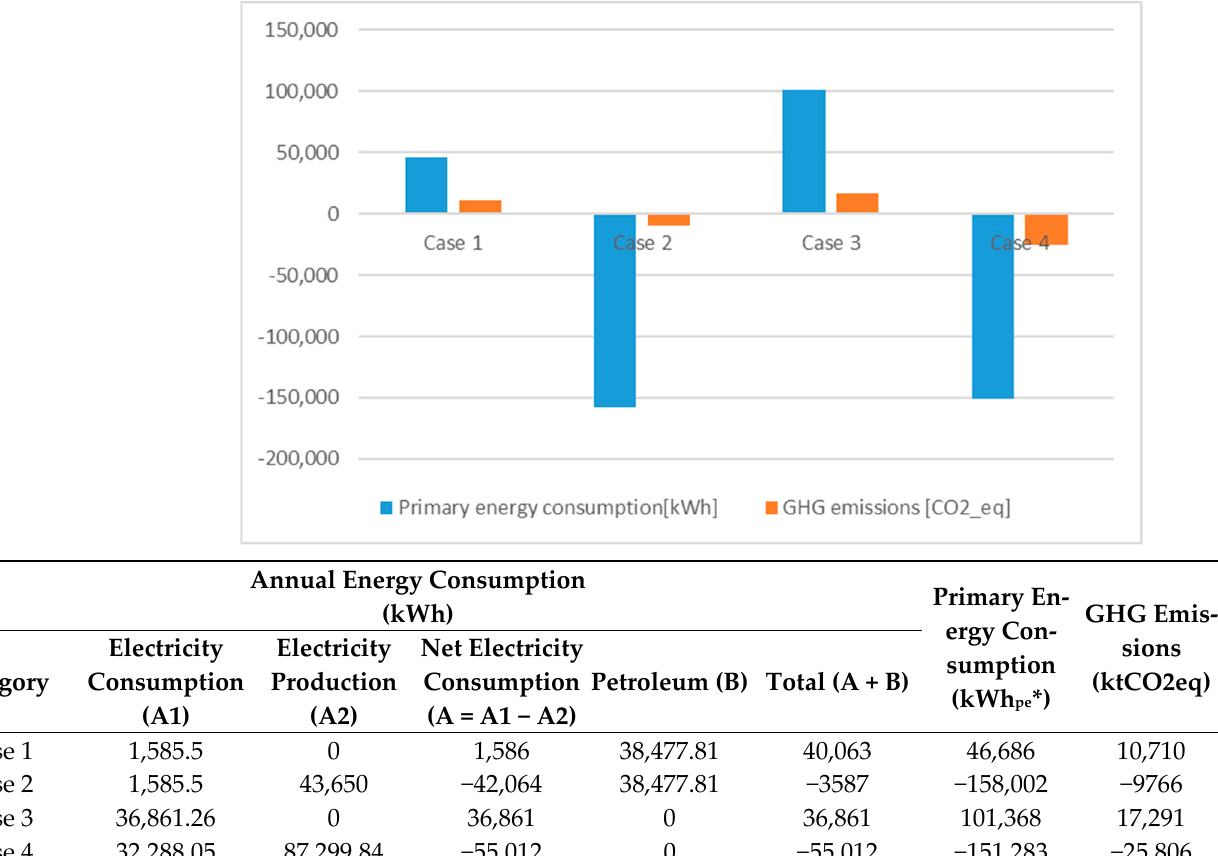
Figure 4. Case-wise annual energy consumption and GHG emissions.